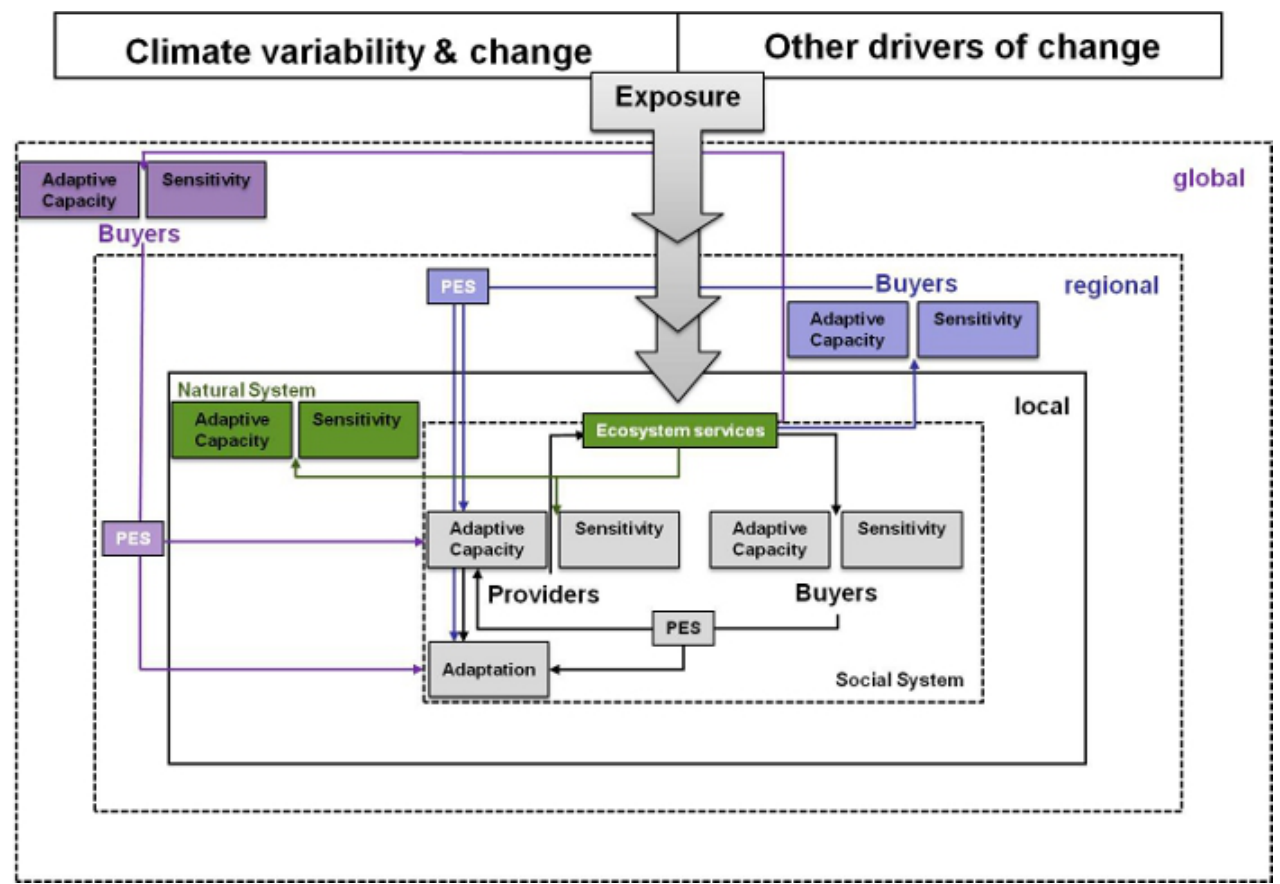
Fig. 1 . Conceptual link between PES, adaptation, and vulnerability of the coupled socioecological system. Source: own illustration, based on Locatelli et al. (2008) and Turner et al. (2003). For reasons of simplicity, the figure only depicts the social system in terms of buyers and